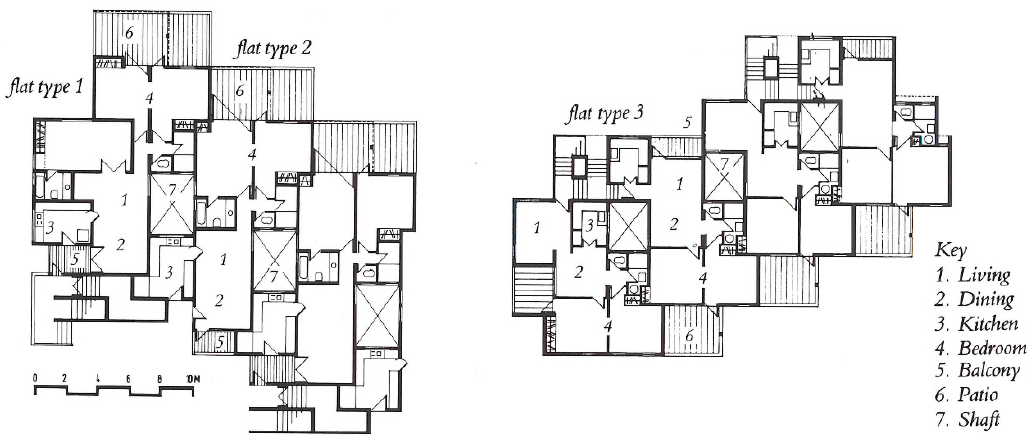
Figure 6. Floor plans showing the internal layouts of the three unit types [19].